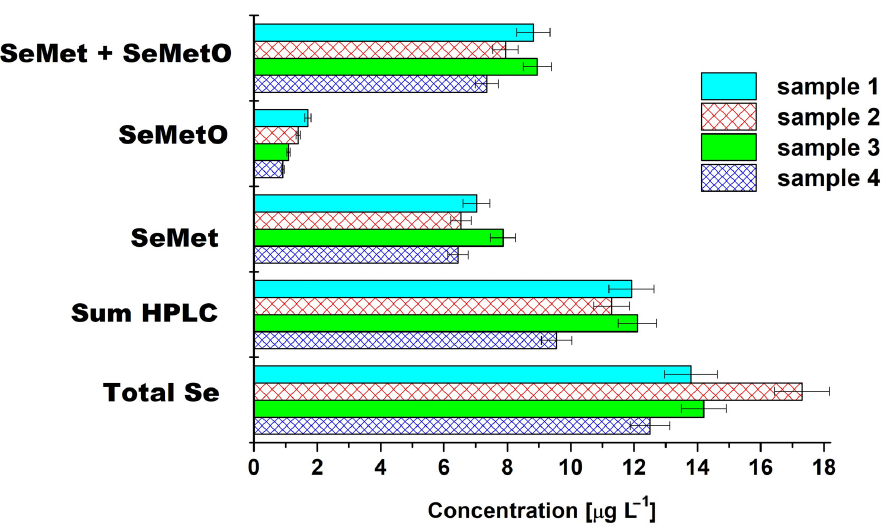
Figure 6. Concentration balance of selenium and its species determined in Lung-Ching green tea samples by ZIC HILIC HPLC separation procedure. Sum HPLC means the sum of the concentrations of SeMet and SeMetO obtained from the chromatographic